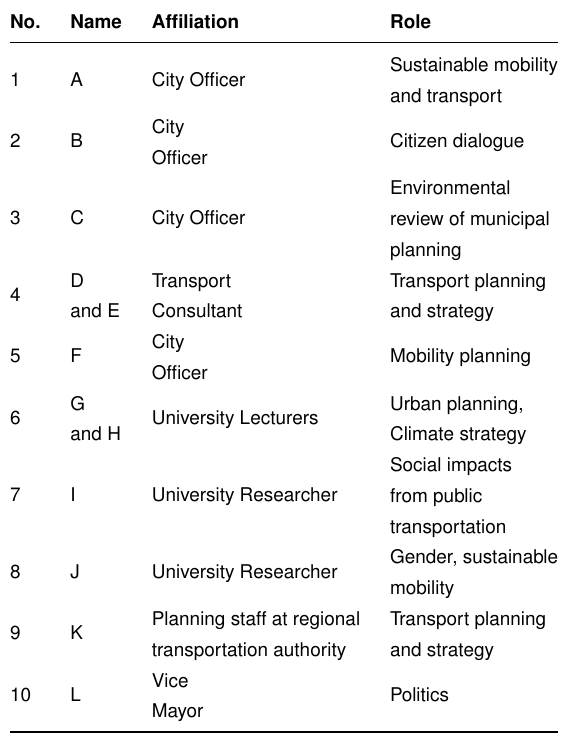
Table 3. List of case study interviewees, all met with in